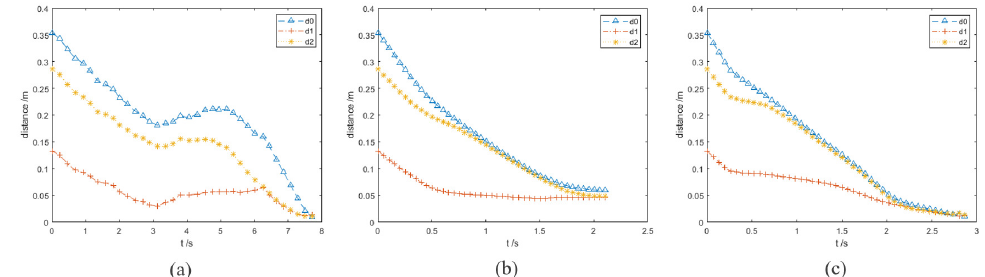
Figure 3. Experiment A: ( a – c ) the running process of the robot arm when using three different algorithms. ( a ) informed RRT*; ( b ) VPF; ( c ) IVPF.